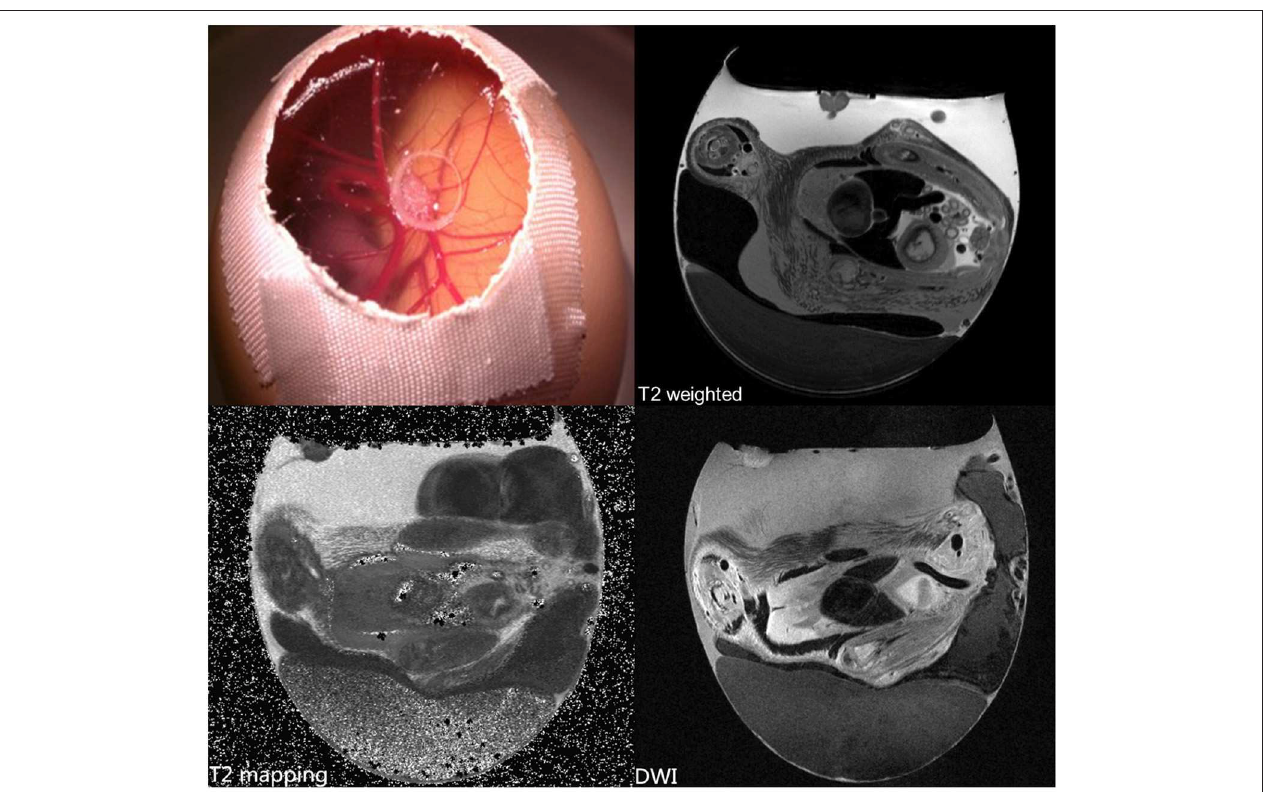
FIGURE 6 | In vivo high-resolution MRI with T2 and diffusion weighting (DWI), and T2 quantification of a Human breast tumor (carcinoma cell line MDA-MB-231) xenotransplanted on the CAM. Unpublished imaging material provided by Zuo obtained with precooling and MR protocols as described in [ 61].